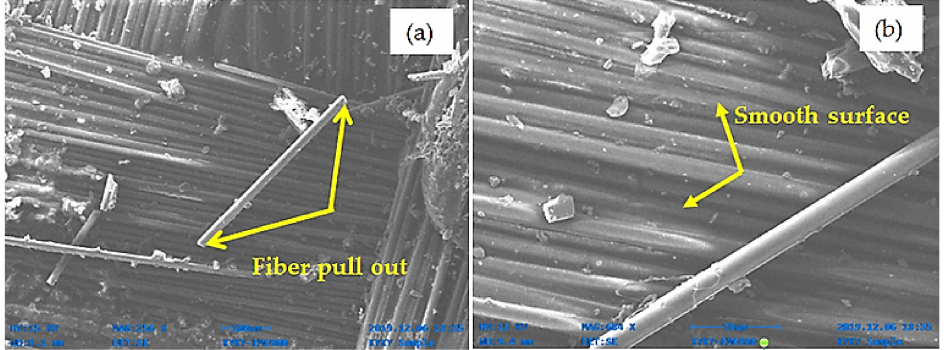
Figure 6. Scanning electron microscope (SEM) images of dry specimens with magnification: ( a ) 256 × and ( b ) 684 ×